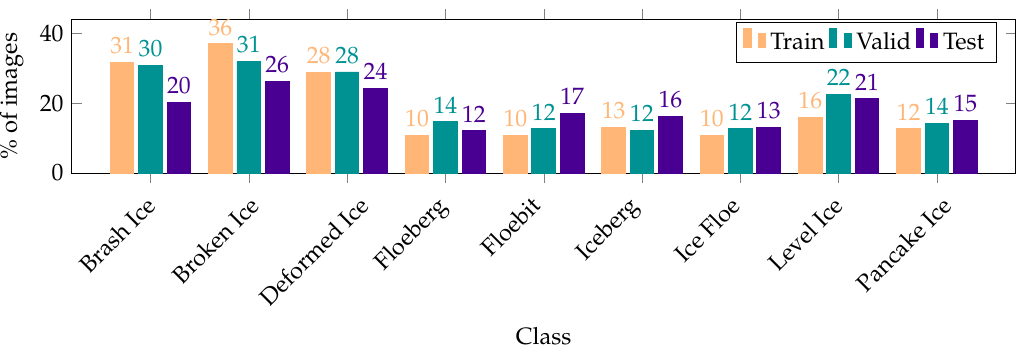
Figure 2. Class balance after the data has been resampled. The plot shows the percentage of the images in each dataset that contains the given class.